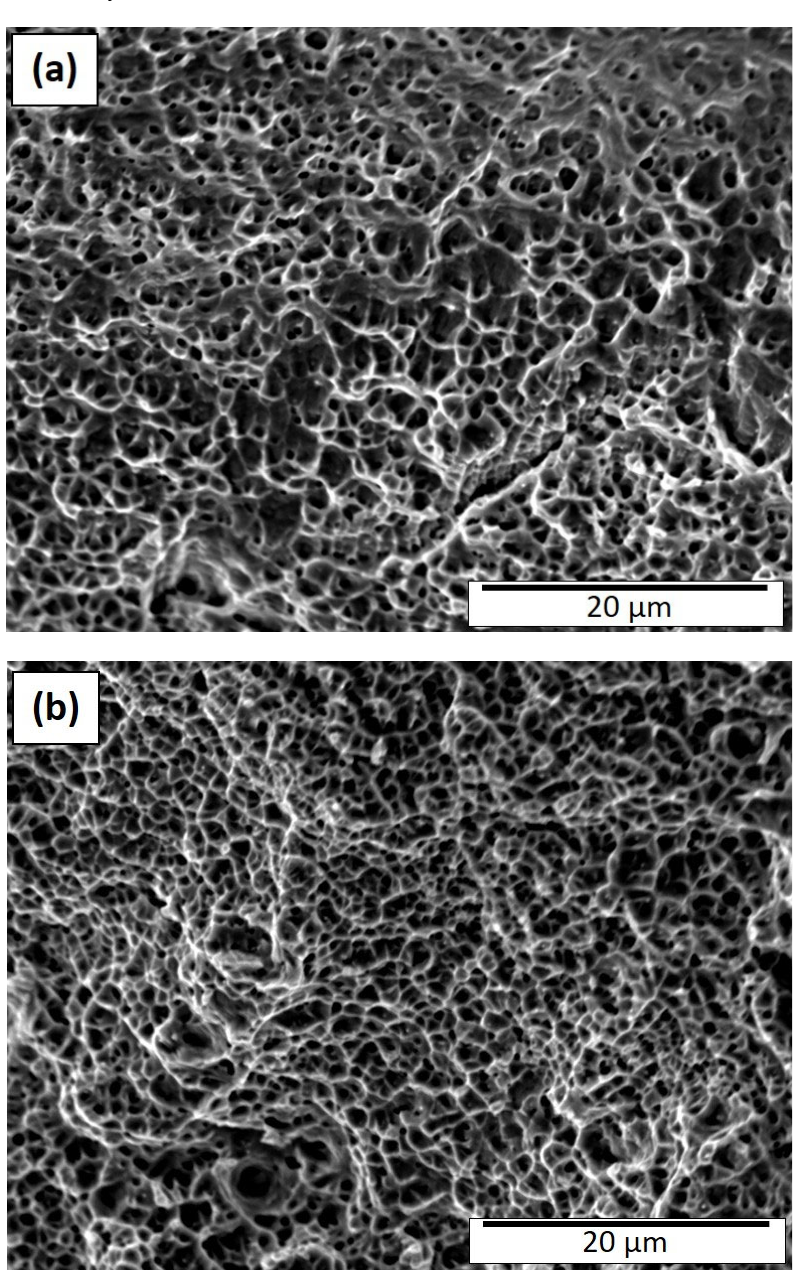
Figure 8. Heat-treated fracture surface (SEM). ( a ) 50 µm layer thickness; ( b ) 100 µm layer thick- ness.